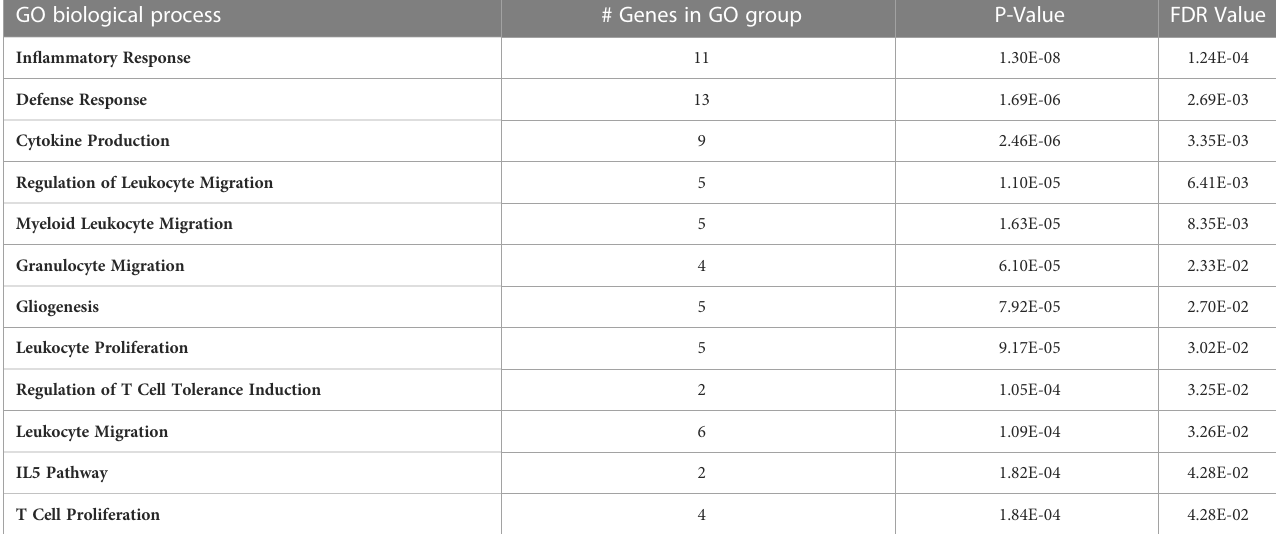
TABLE 4 Gene ontology de fi ned biological processes associated with total IgE levels in the bi-directionally replicated transcripts between the FHS and GACRS/CAMP cohorts (n=59). GO biological process # Genes in GO